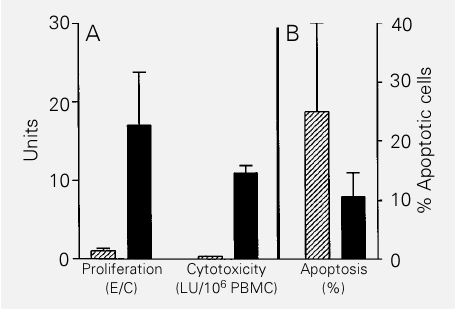
Figure 1 - Effect of IL-12 on the responsiveness of PBMC from visceral leishmaniasis (VL) pa- tients. Panel A shows that the addition of IL-12 + Leishmania antigen (black bars) reversed both lymphocyte proliferation (proliferation reported as stimu- lation index = E/C) and cytotoxic responses against K562 tumor target cells (cytotoxicity re- ported as lytic units (LU) per mil- lion PBMC), as compared to cells receiving Leishmania anti- gen alone (hatched bars). In Panel B the addition of IL-12 + Leishmania antigen (black bars) partially reversed the rate of an- tigen-induced (hatched bars) PBMC apoptosis in VL patients (results are reported as percent- age of apoptotic cells as evi- denced by propidium iodide staining and FACS analyses). Bars represent the mean – SD of at least six determinations.